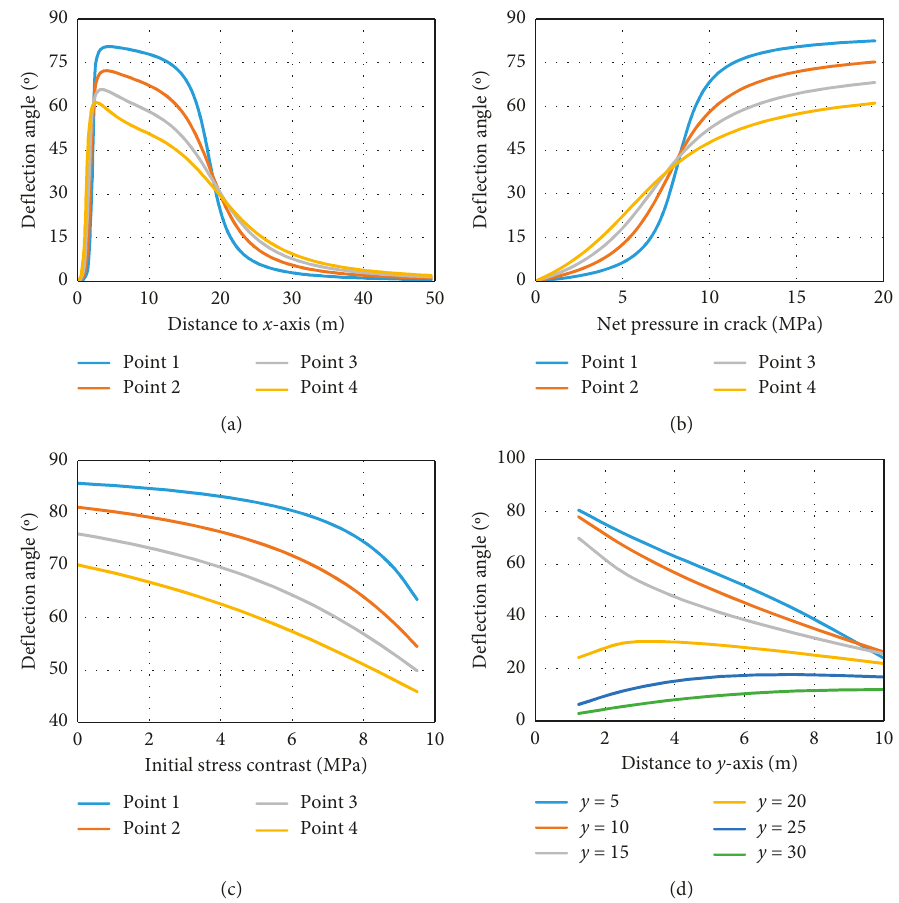
Figure 10: Deflection angle of principal stress (a) with D to the y